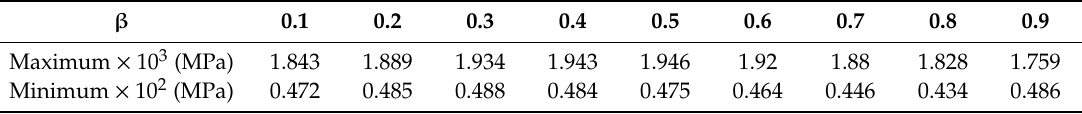
Table 2. Maximum-minimum equivalent stress of variable-angle laminates of [0 ± < 20 ( β ) 60 > ] 2s